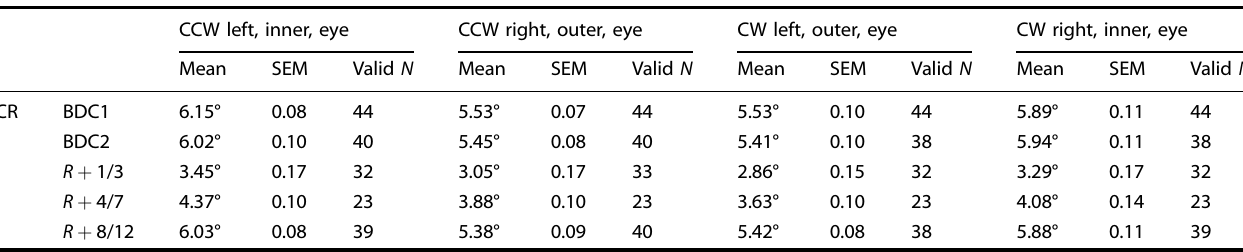
were kept in the model according to their Likelihood ratio tests ( p < 0.0001 for all). Given the signi fi cant term Eye*Orientation, we created a new interaction term Eye_Rotation de fi ning the inner and outer eye with respect to the rotational axis of the centrifuge. Dunnett ’ s correction for multiple testing was used for the post hoc